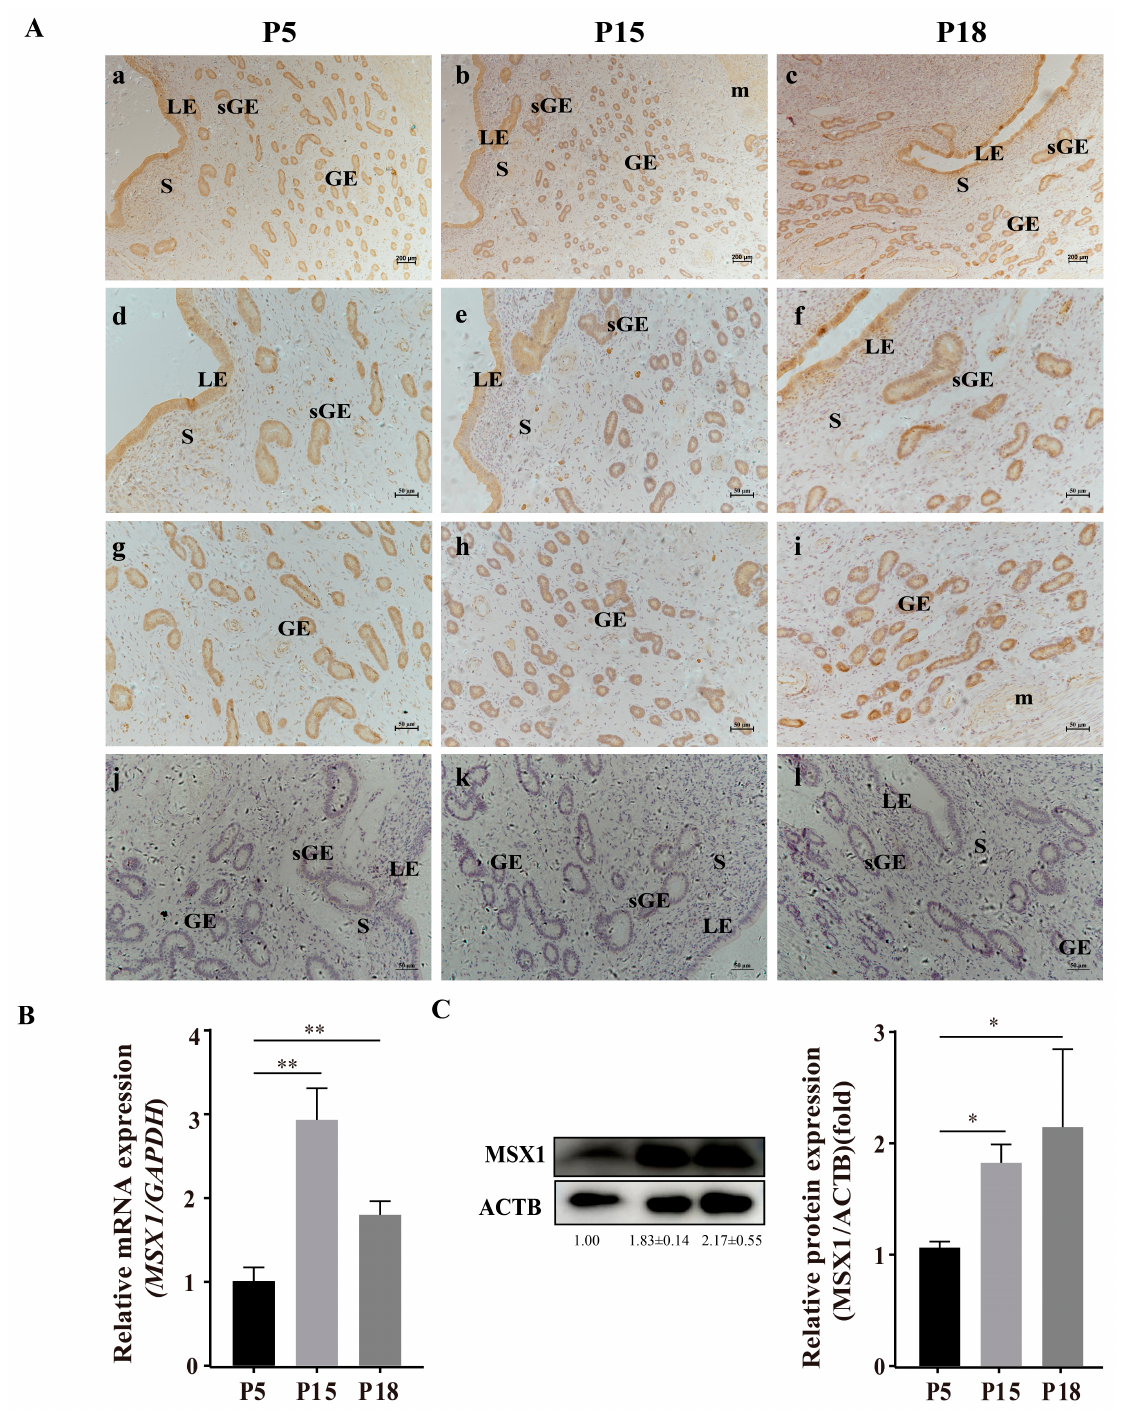
Figure 1. Representative images of MSX1 immunolocalization and expression in goat endometrial tissue at pregnancy at days 5, 15, and 18. ( A ) Representative images of MSX1 immunolocalization in goat endometrial tissue at pregnancy at days 5, 15, and 18: ( a , d , g ) MSX1 immunolocalization in goat endometrial tissue on P5 (n = 3); ( b , e , h ) MSX1 immunolocalization in goat endometrial tissue on P15 (n = 3); ( c , f , i ) MSX1 immunolocalization in goat endometrial tissue on P18 (n = 3); ( j – l ) negative control in goat endometrial tissue on P5, P15, and P18. ( B ) The mRNA expression level of MSX1 in P5, P15, and P18. ( C ) Western blot and analysis of MSX1 protein in P5, P15, and P18. LEs: luminal epithelial cells; sGE: superficial glandular epithelium; GEs: glandular epithelial cells; S: stromal cells; m: myometrium. ( a – c ) scale bar = 200 μ m; ( d – l ) scale bar = 50 μ m. * p < 0.05; ** p < 0.01.